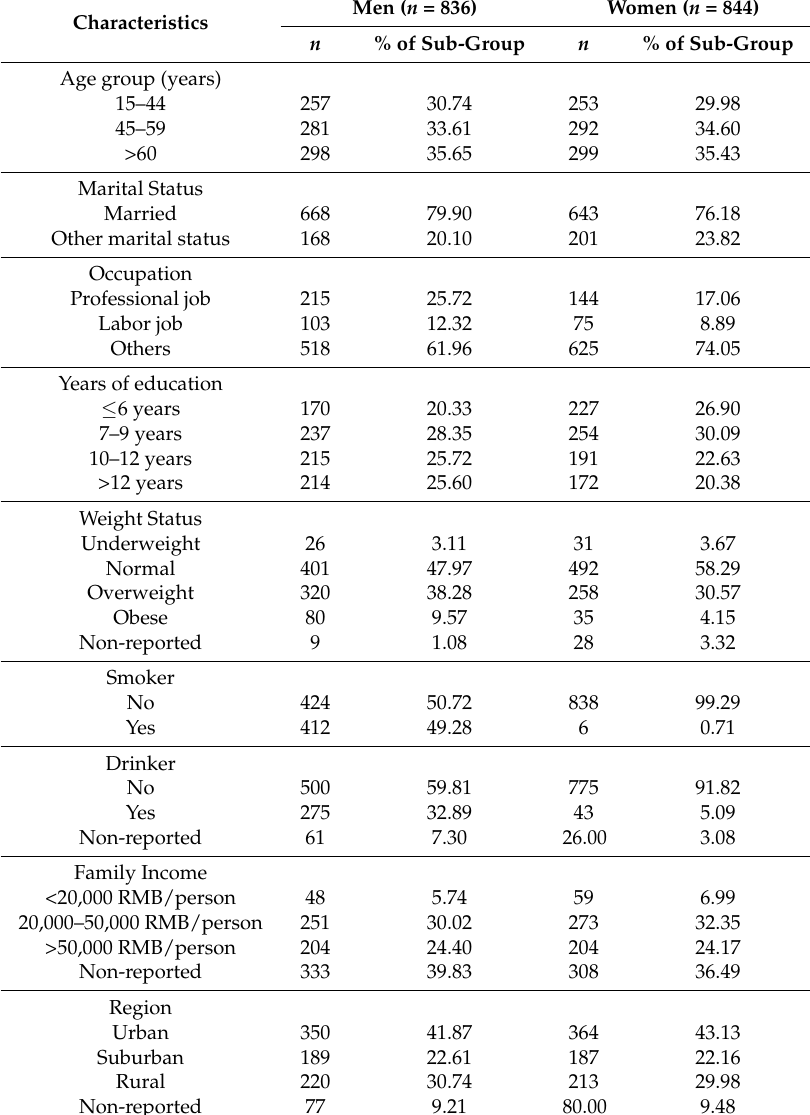
Table 1. Characteristics of study